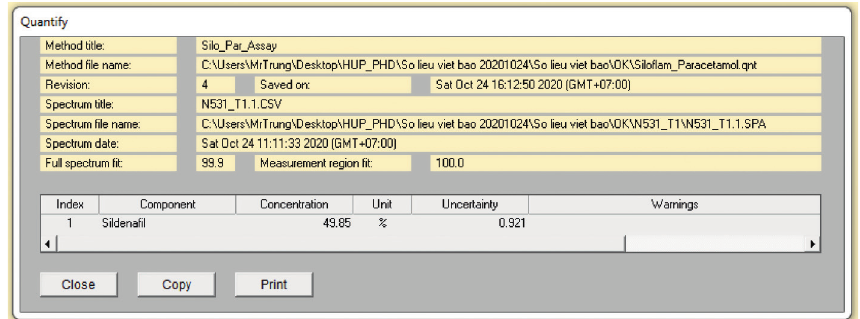
Figure 4: Determining R value of mixture of N531 powder and